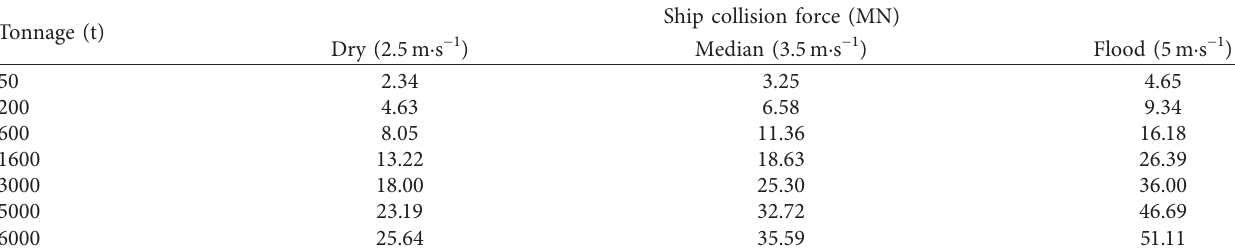
Table 4: Predictive values of ship collision force with 84% rate guarantee.